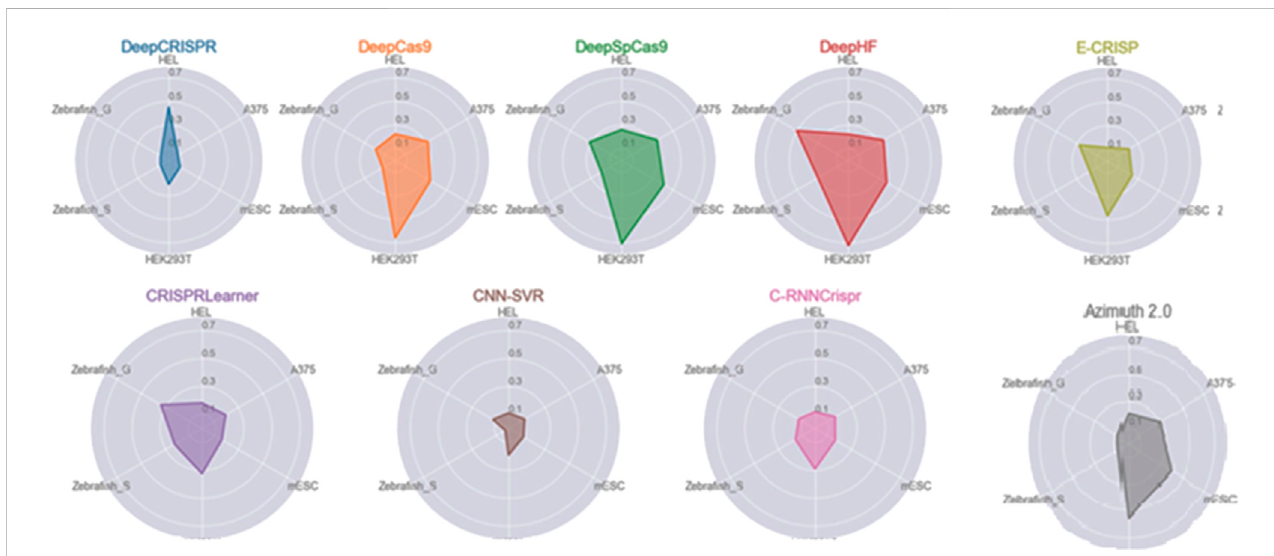
FIGURE 7 Spearman correlation for ML-based tools over the different datasets. Each polygon represents a tool, and the edges illustrate the obtained correlation over the respective